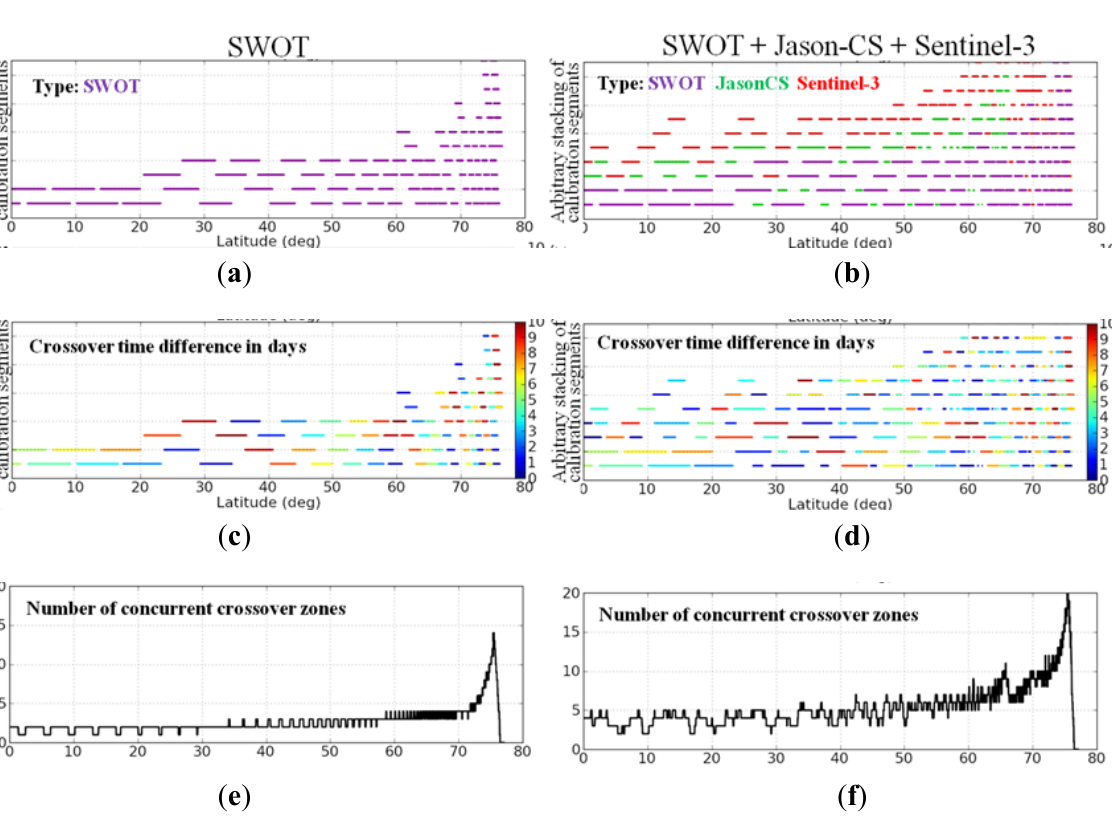
Figure 17. Overview of crossover calibration zones if SWOT is used alone ( left panel ), or in combination with Jason-CS and Sentinel-3 ( right panel ). In the upper panels, each colored segment is one calibration zone (stacked arbitrarily if there are two or more at a given latitude). New types of crossover zones ( a , b ) can be used with external nadirs, thus increasing the probability to find crossover with a short time difference between co-located measurements ( c , d ), increasing the number of overlapping calibration zones seen by KaRIN’s image ( e , f